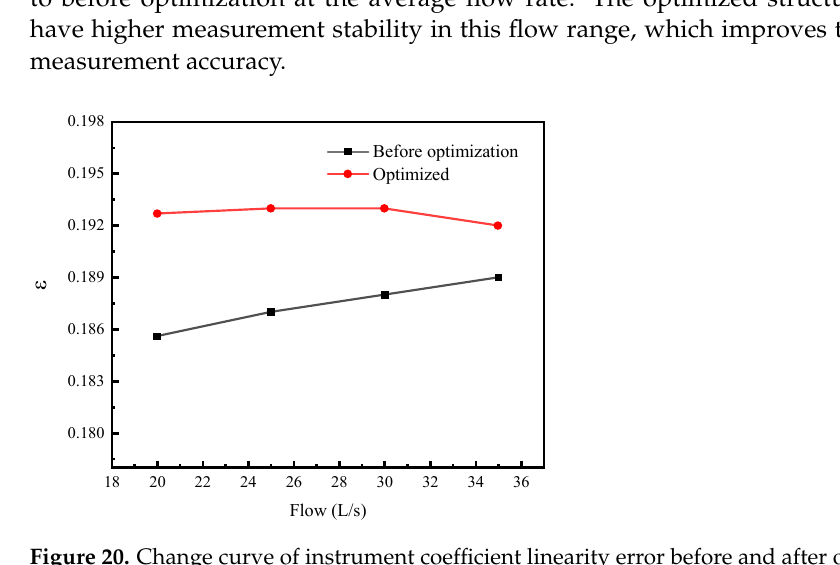
Figure 20. Change curve of instrument coefficient linearity error before and after optimization.